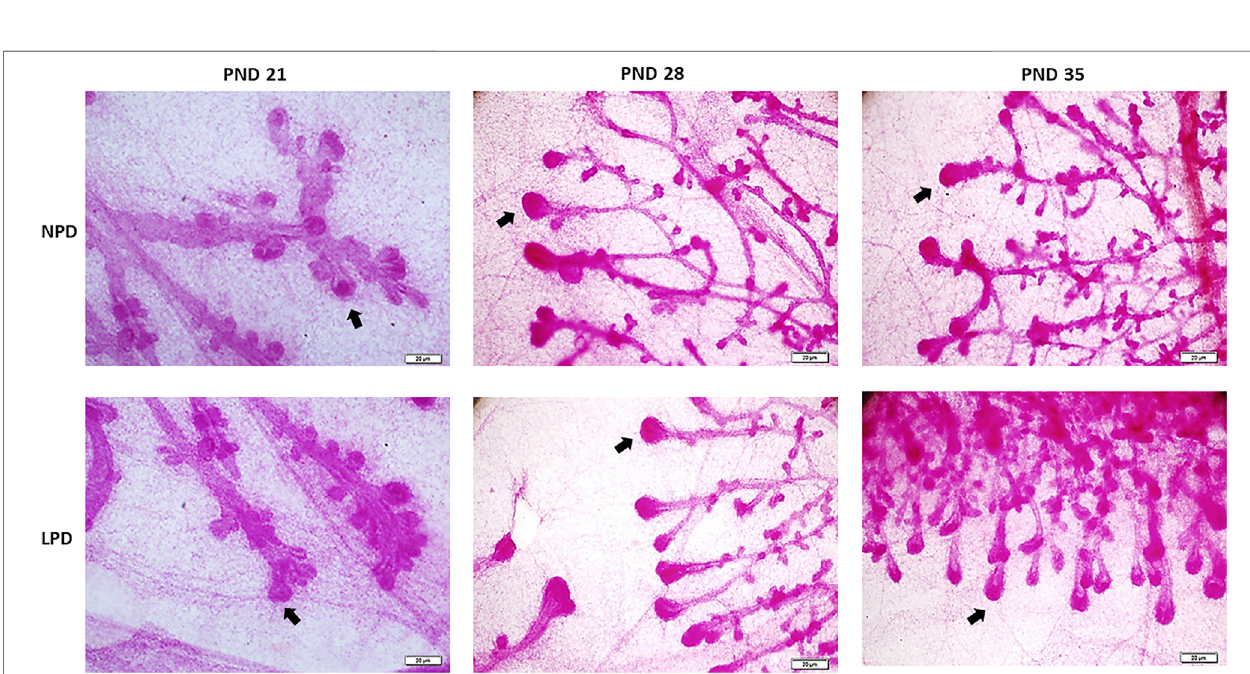
FIGURE3| Theterminalendbuds(blackarrows)intheexternalmarginofthemammarygland.NPD,normoproteindiet;LPD,low-proteindiet;PND,postnatalday (scale bar (cid:1) 20 µm).